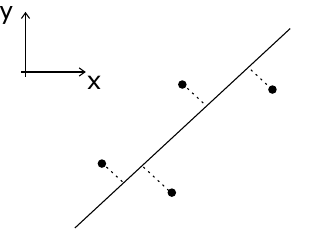
Figure 9: Line fitting done with orthogonal regression